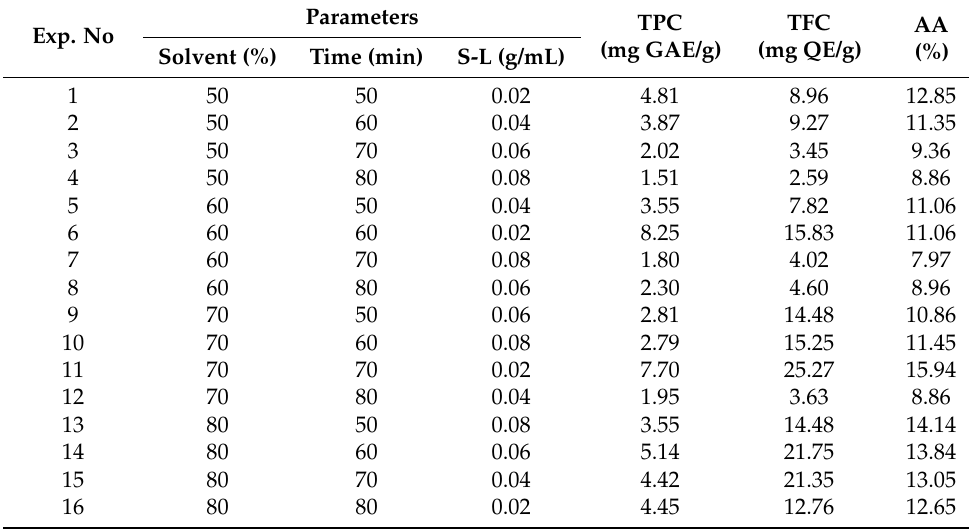
Table 1. Experimental design (orthogonal array L 16 ) and measured results using C. zedoaria . Exp.